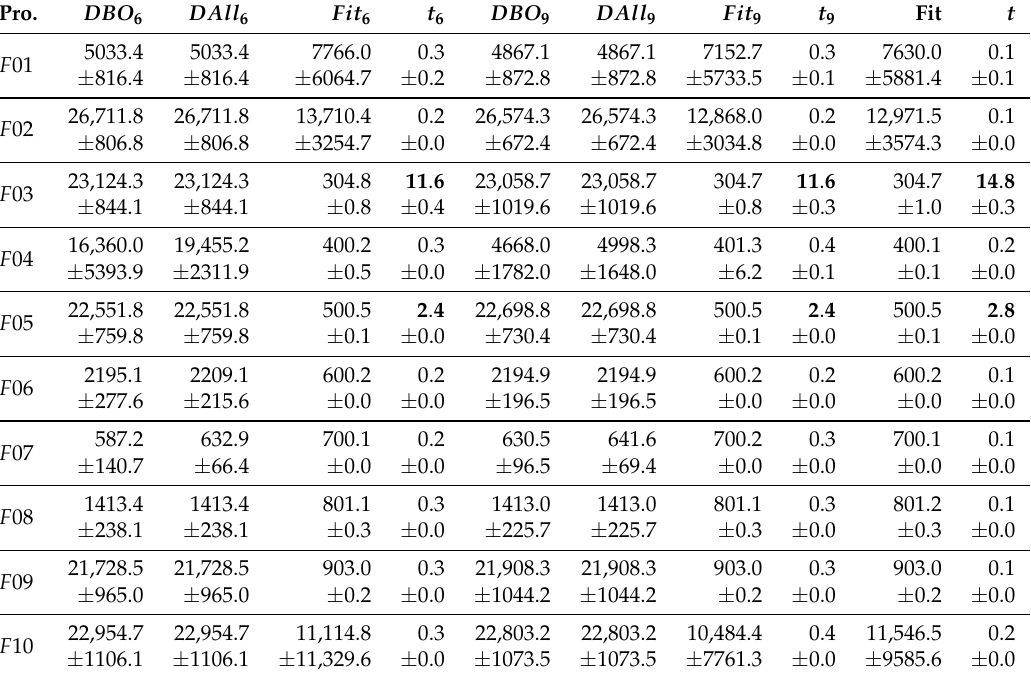
Table 7. ABC algorithm on CEC-2015 with LTMA t .